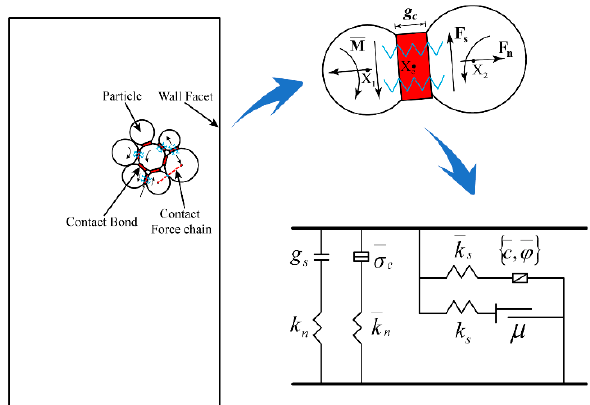
Figure 1. Particle contact and parallel bond model.